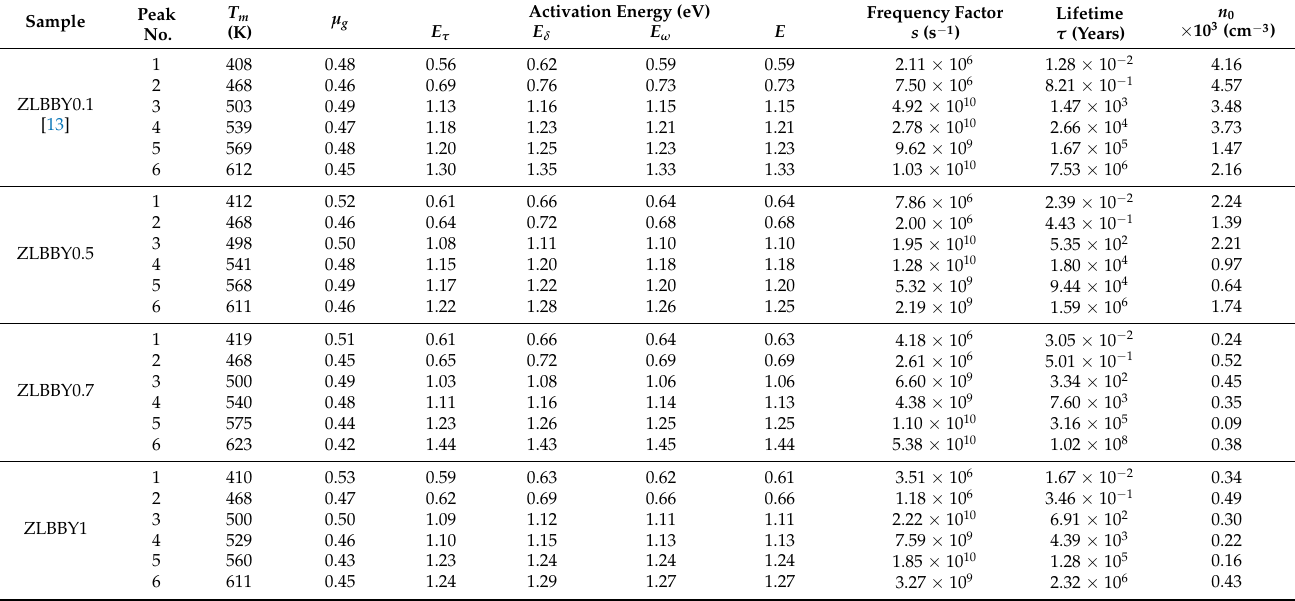
Table 2. Trap parameters of the ZLBBY glasses computed by Chen’s peak shape technique. Sample Peak